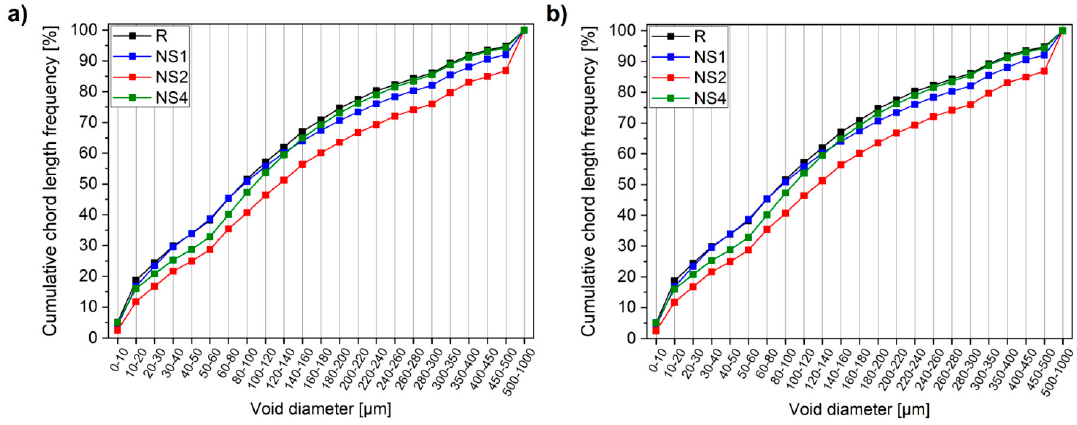
Figure 9. Total porosity ( a ) and cumulative chord length frequency ( b ) of concretes determined with a RapidAir device.